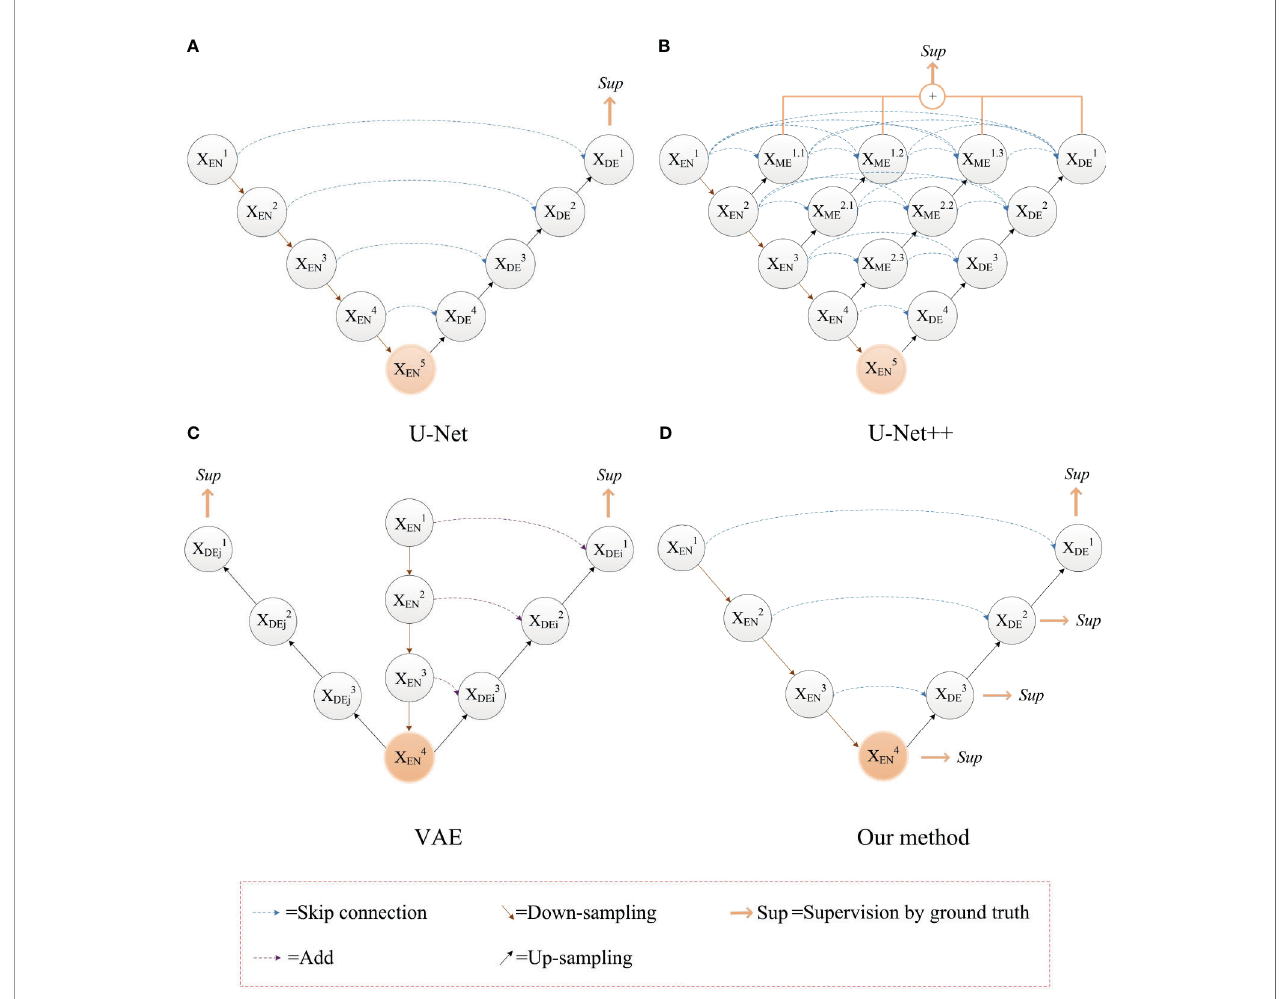
FIGURE 3 | The comparison between our proposed deep supervision method and other methods. (A) The U-Net model; (B) Use of multiple shortcuts and skip connections: this method adds a deep supervision method to each level of sub network, which affect the hierarchical feature expression ability of network (35); (C) Use of image reconstruction task as deep supervision to prevent the network from over fi tting (24). (D) Our method with deep